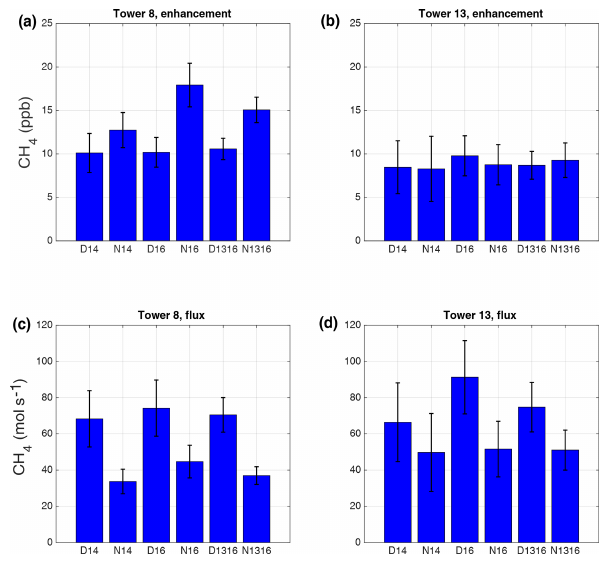
Figure 7. Averages of the daytime (D) and nighttime (N) CH 4 en- hancements and fluxes at INFLUX towers 8 and 13 for years 2014 (14), 2016 (16), and 2013–2016 (1316). The error bars represent the 95% confidence interval of each mean value. (a) Estimates of CH 4 enhancements from tower 8. (b) Estimates of CH 4 enhancements from tower 13. (c) Estimates of CH 4 flux from tower 8. (d) Esti- mates of CH 4 flux from tower